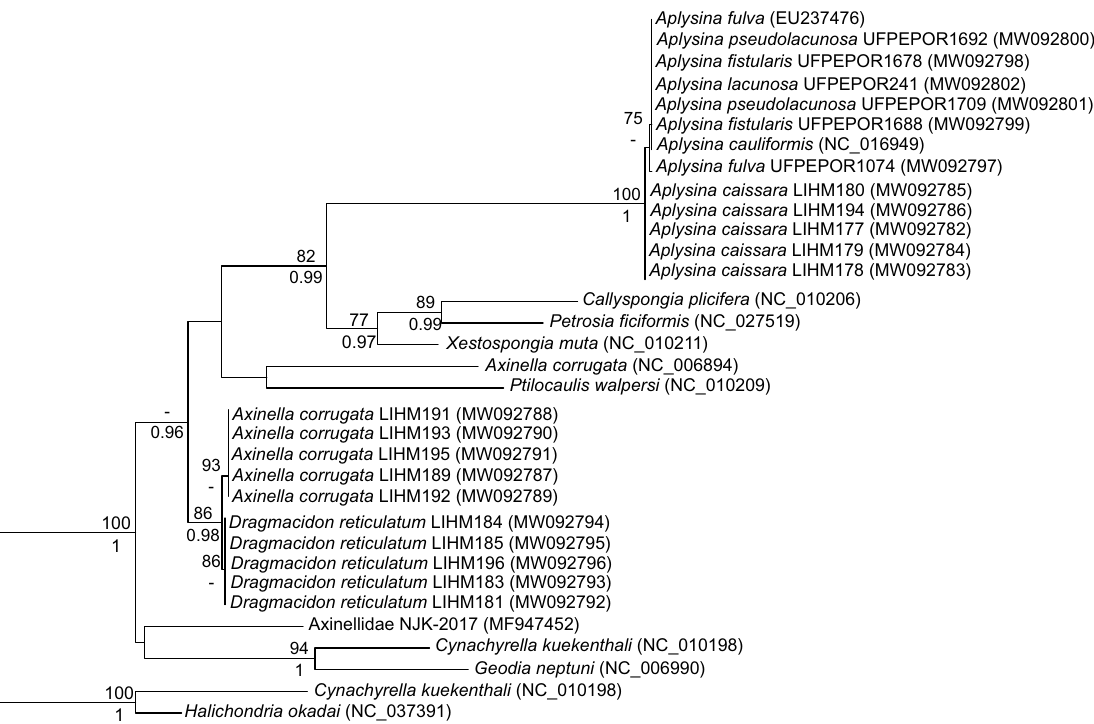
Figure 1. Phylogenetic inference of the Axinellidae and Aplysinidae families based on the cytochrome b. The Maximum Likelihood tree (-ln likelihood: -2655.123092) is shown. ML bootstrap values (> 75%) and Bayesian posterior probabilities (> 0.95) are shown above and below branches, respectively.